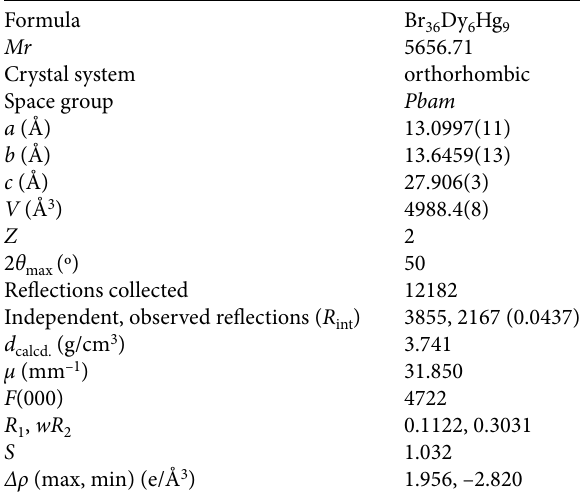
Table 1. Crystal data and structure refinement details.